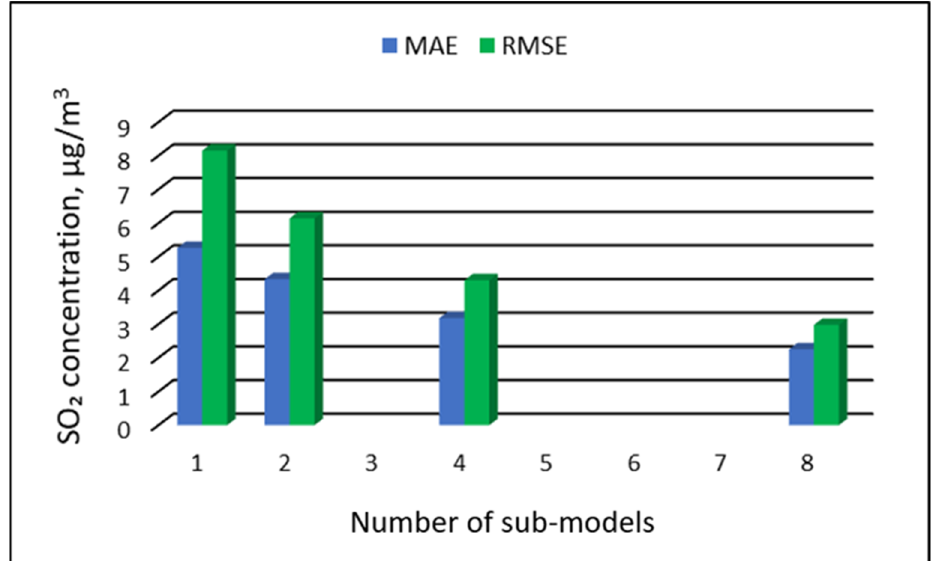
Table 18. Values of approximation errors of SO 2 concentrations in RVS models, Z ł oty Potok 2011– 2016.